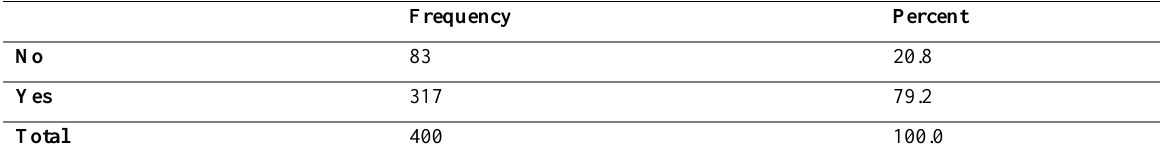
Table 1 : Understanding of the IDP and community